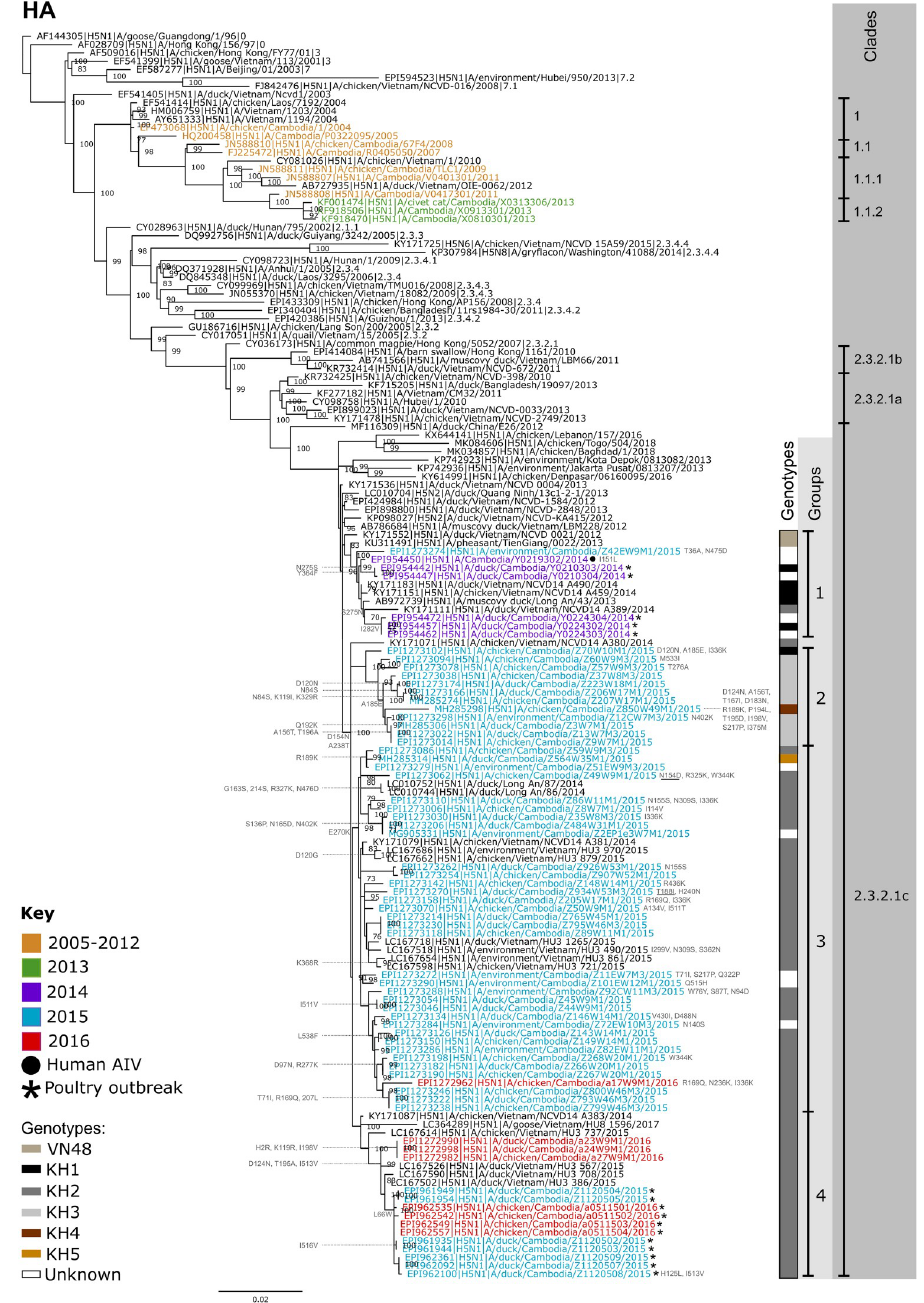
Fig 2. Maximum likelihood phylogenetic tree for the HA gene of A(H5) AIVs. The tree was generated with IQ-Tree using GTR+ Γ and 1,000 ultrafast bootstrap replicates. Cambodian viruses are coloured based on the year they were collected. Viruses detected prior to 2013 are coloured orange, viruses from 2013 are green, viruses from 2014 are purple, 2015 are blue and 2016 are red. Viruses detected during poultry outbreaks are indicated by an asterisk ( � ) and the single clade 2.3.2.1c Cambodian human A(H5N1) is indicated by a black circle next to the taxa name. Viral clades, HA groups and genotypes are indicated on the right hand side of the tree. Viral clades not listed on the right hand side of the tree have been appended to the end of taxa names. Amino acid differences relative to the closest related WHO candidate vaccine virus (A/duck/Vietnam/NCVD-1584/2012) are shown next to the phylogeny in grey. Mutations listed at branches on the left side of the tree prevail in descendant viruses. Mutations listed next to viral taxa on the right side of the tree are found in the individual virus. Underlined mutations are those that have been previously reported to affect viral fitness. Bootstrap values of 70 or greater are displayed on